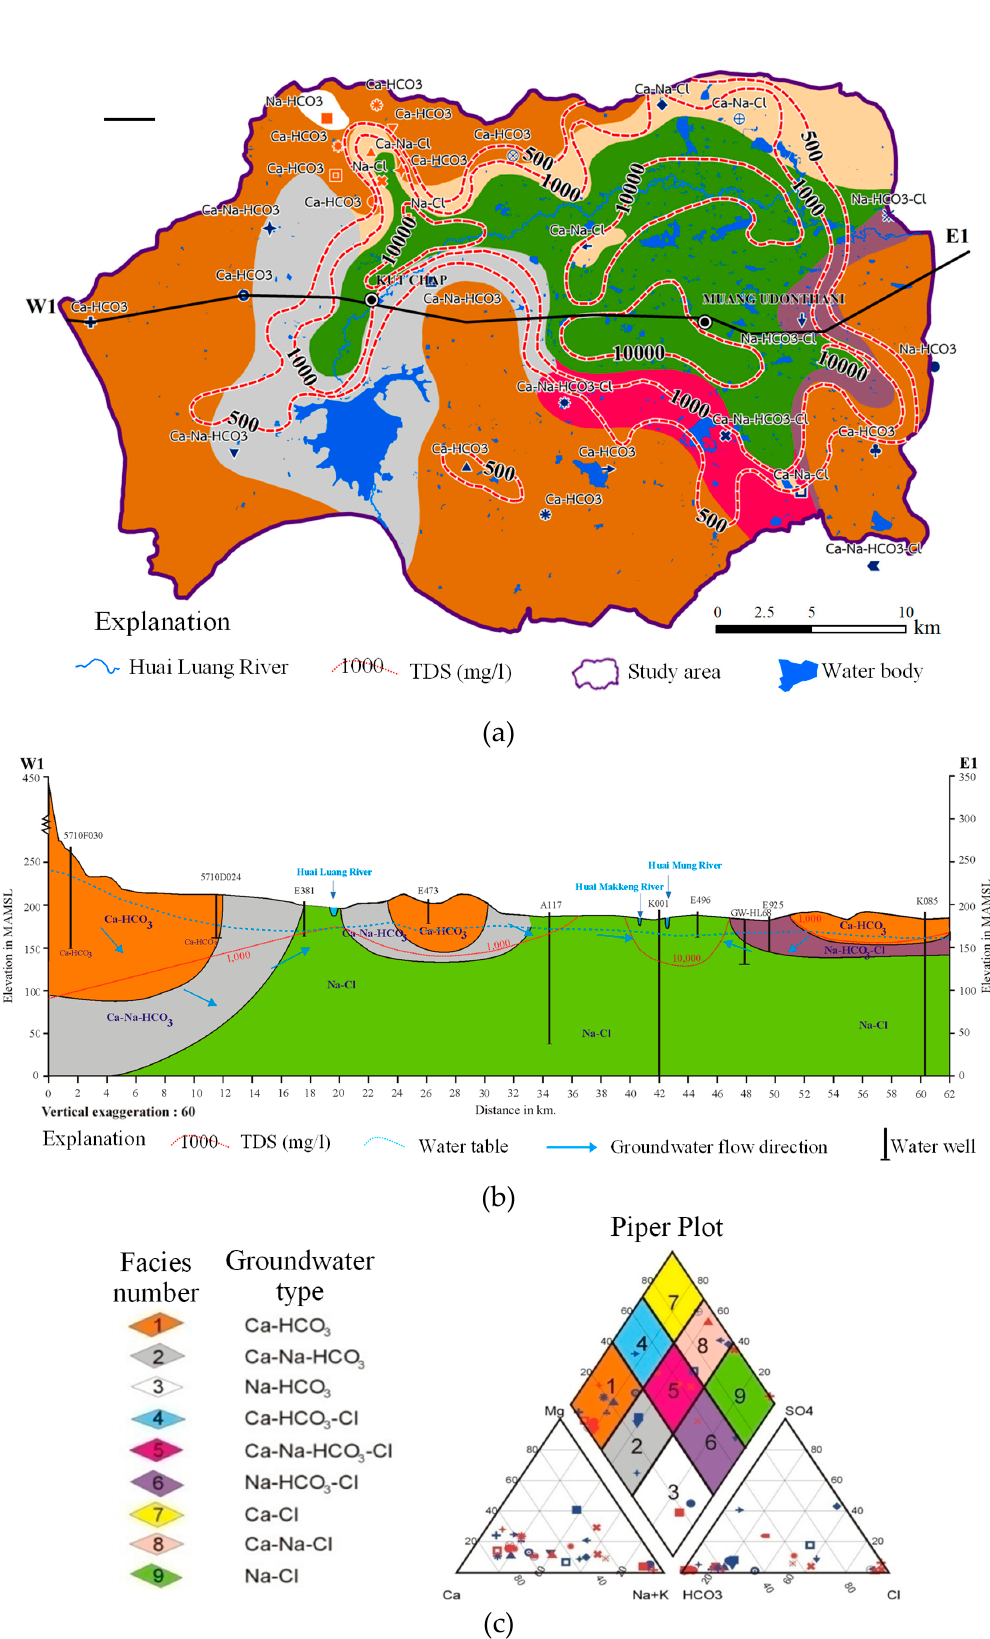
Figure 6. Groundwater type of CHLB. ( a ) Hydrogeochemical facies map; ( b ) Hydrogeochemical facies cross section along line W1 to E1 ; ( c ) Piper plot diagram of groundwater samples.